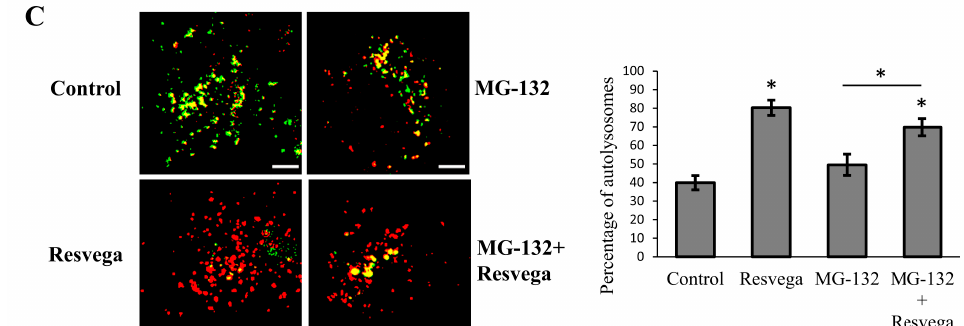
Figure 1. ARPE-19 cells were treated with 288 ng Resvega, 1 µ M MG-132 or their combination for 6 h, 12 h, and 48 h in normal growth conditions. The protein level of p62 ( A ) and LC3-I/LC3-II ( B ) were analyzed by Western blot, while the expression was quantified in a comparison to α -tubulin and presented as fold change compared to control; and ( C ) cells were transfected with mCherry-GFP-LC3-plasmid and treated for 12 h, the fluorescence was then determined by fluorescence microscopy, red (autolysosomes) and yellow (autophagosomes) dots were counted and presented as the percentage of autolysosomes. Scale bar: 5 µ m. Western blotting data are shown as mean ˘ SD ( n = 3), and the percentage of autolysosomes is shown as mean ˘ SEM ( n = 9–12). * p < 0.05,